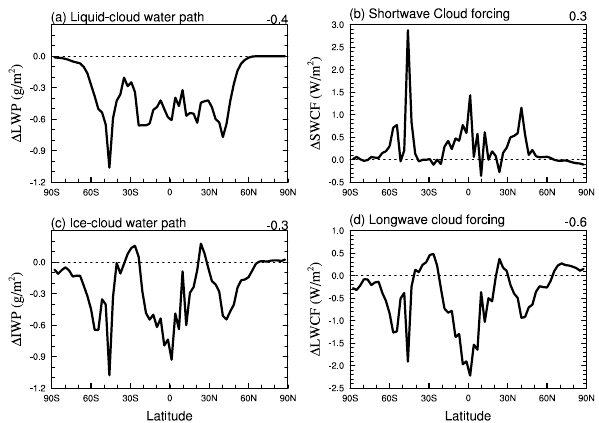
Fig. 7. Changes of liquid-cloud water path (a) , surface shortwave cloud forcing (b) , ice-cloud water path (c) and surface longwave cloud forcing (d) between 50% ozone reduction and the control ex- periment. The CO 2 level is 100ppmv. Global-mean value is shown at the right top of each